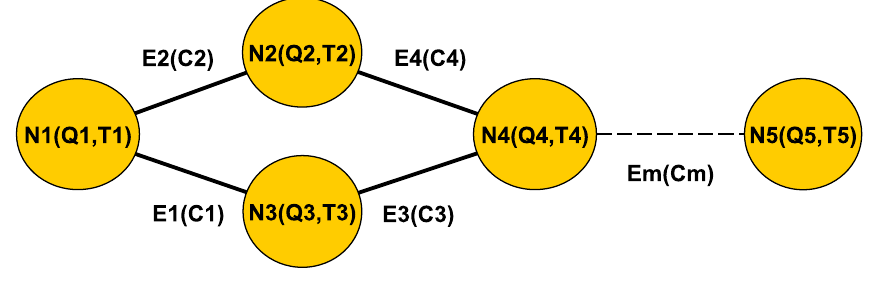
Figure 1. Example of a graph of